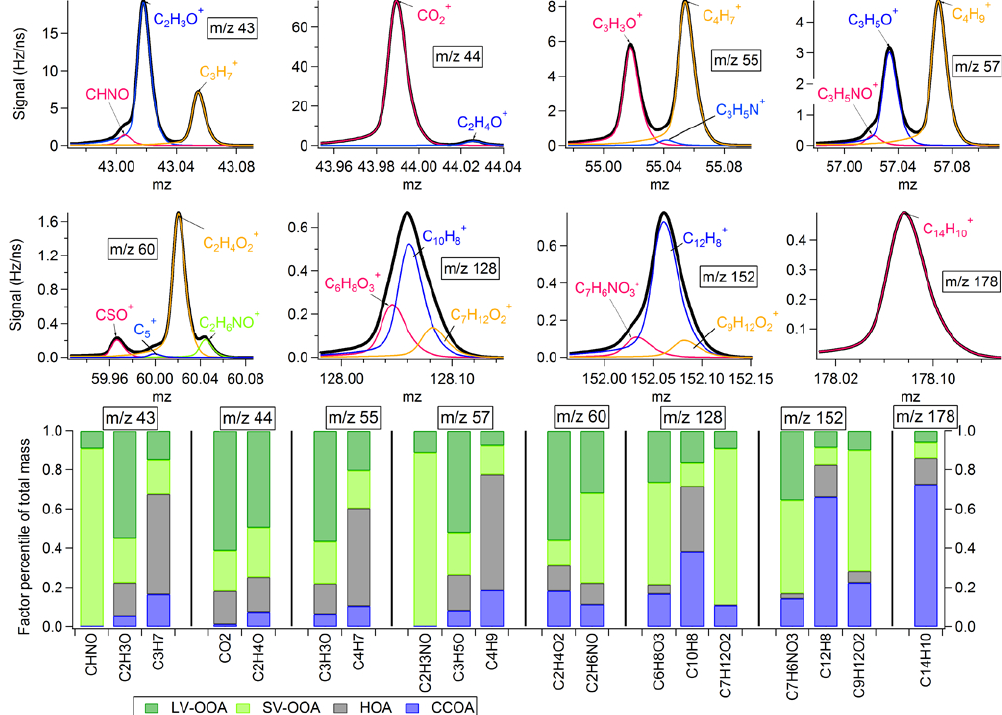
Fig. 7. High resolution ion signals for important organic fragment ions (upper graphs). The signals are shown for a specific point in time (at 20:38LT on 7 April) with high organic concentrations as an example. Only the ions used in the PMF are shown here. The average contributions of each OA component to the specific ions are shown in the lower graphs.